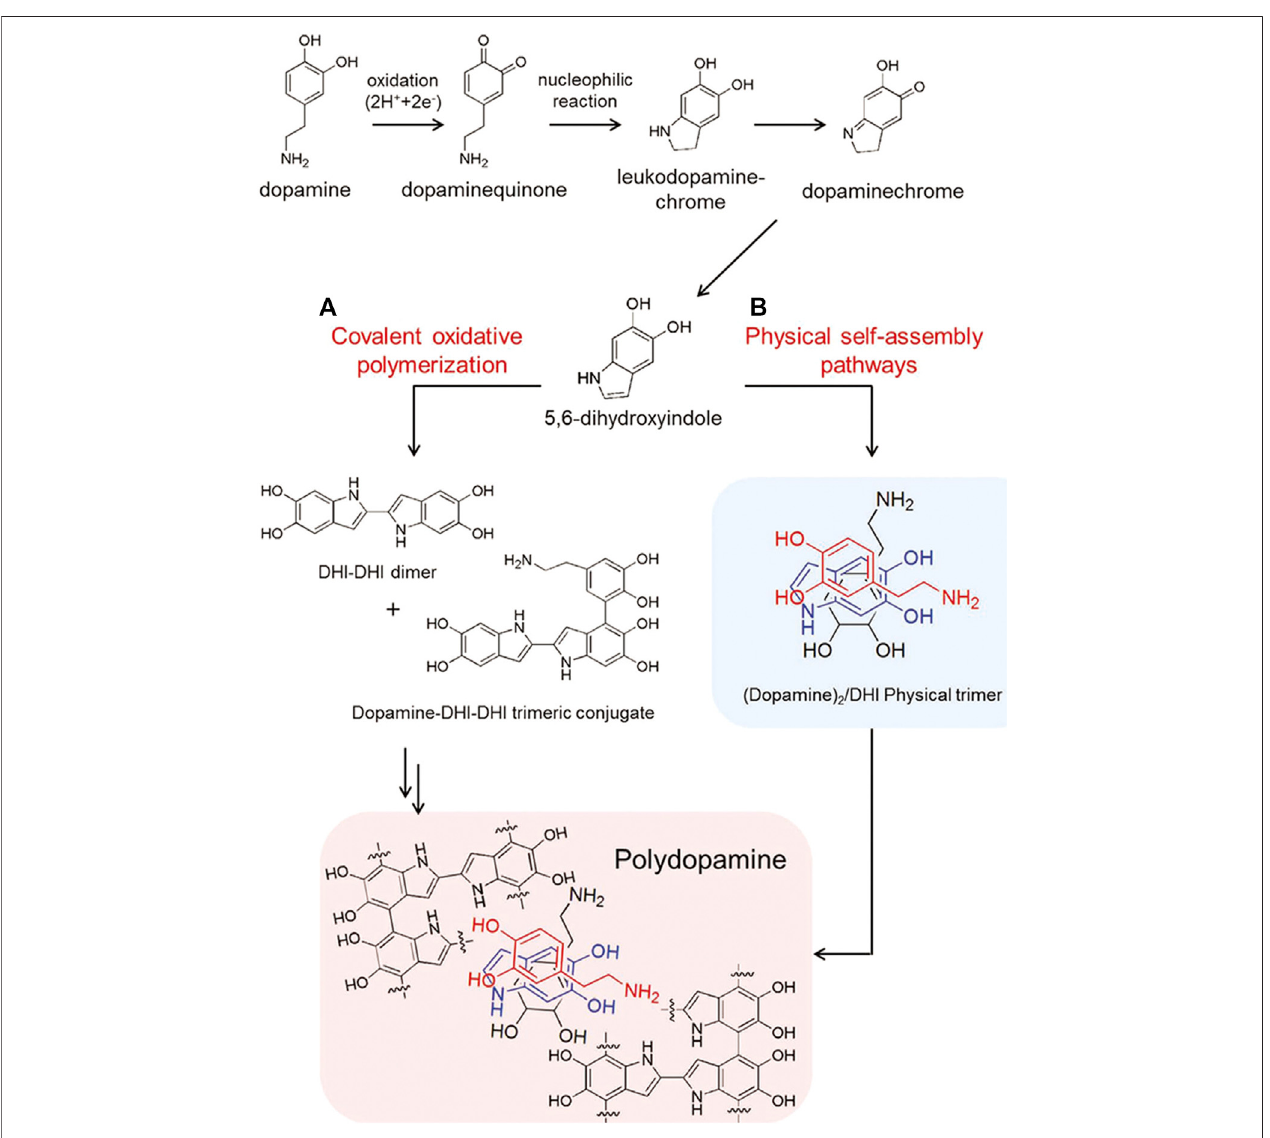
FIGURE 3 | Schematic illustration for synthesis of PDA via two pathways: (A) covalent oxidative polymerization and (B) physical self-assembly pathways (Hong et al., 2012). Copyright 2012, Wiley-VCH.